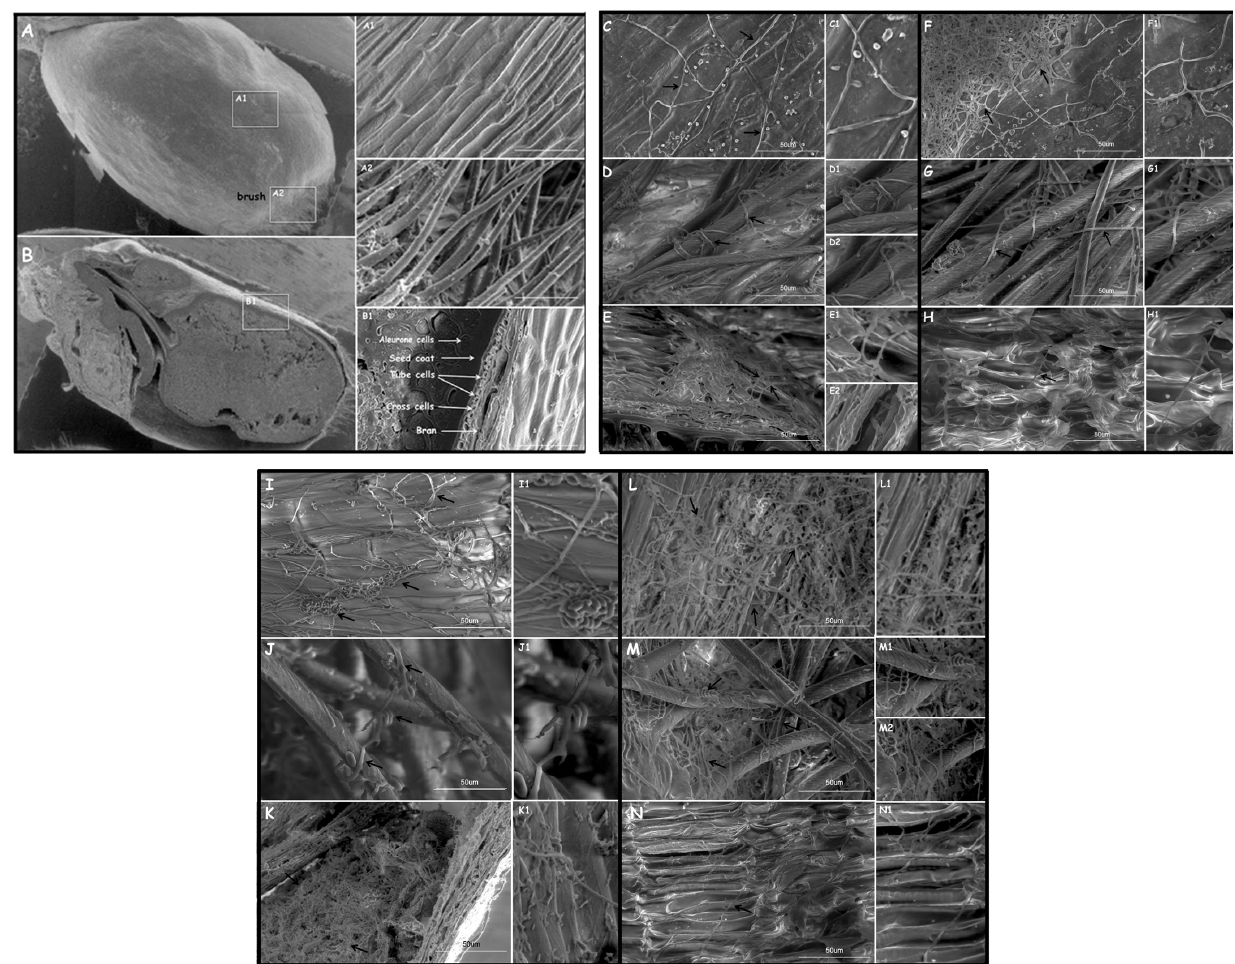
Figure 8. Electron scanning micrography of control wheat kernels not inoculated and treated with Trichoderma and Clonostachys and not infected with F. culmorum KF846. On panel ( A ) and ( B ) are control kernels of wheat. On panels ( C – E ) the wheat kernel treated with T. viride AN430 (black arrows) are visible. Panels ( F – H ) present the wheat kernel treated with T. atroviride AN240 (black arrows). On panels ( I – K ) the kernels treated with C. rosea AN291 (black arrows) are presented. Panels ( L – N ) show the kernel treated with F. culmorum KF846 (black arrows). In each panel bran, brush and section are presented, respectively: ( A1,C,C1,I,I1,L,L1 )—magnification on bran; ( A2,D,D1,D2,G,G1,J,J1,M,M1,M2 )—magnification of brush; ( B1,E,E1,E2,H,H1,K,K1,N,N1 )—magnification on wheat kernel section.